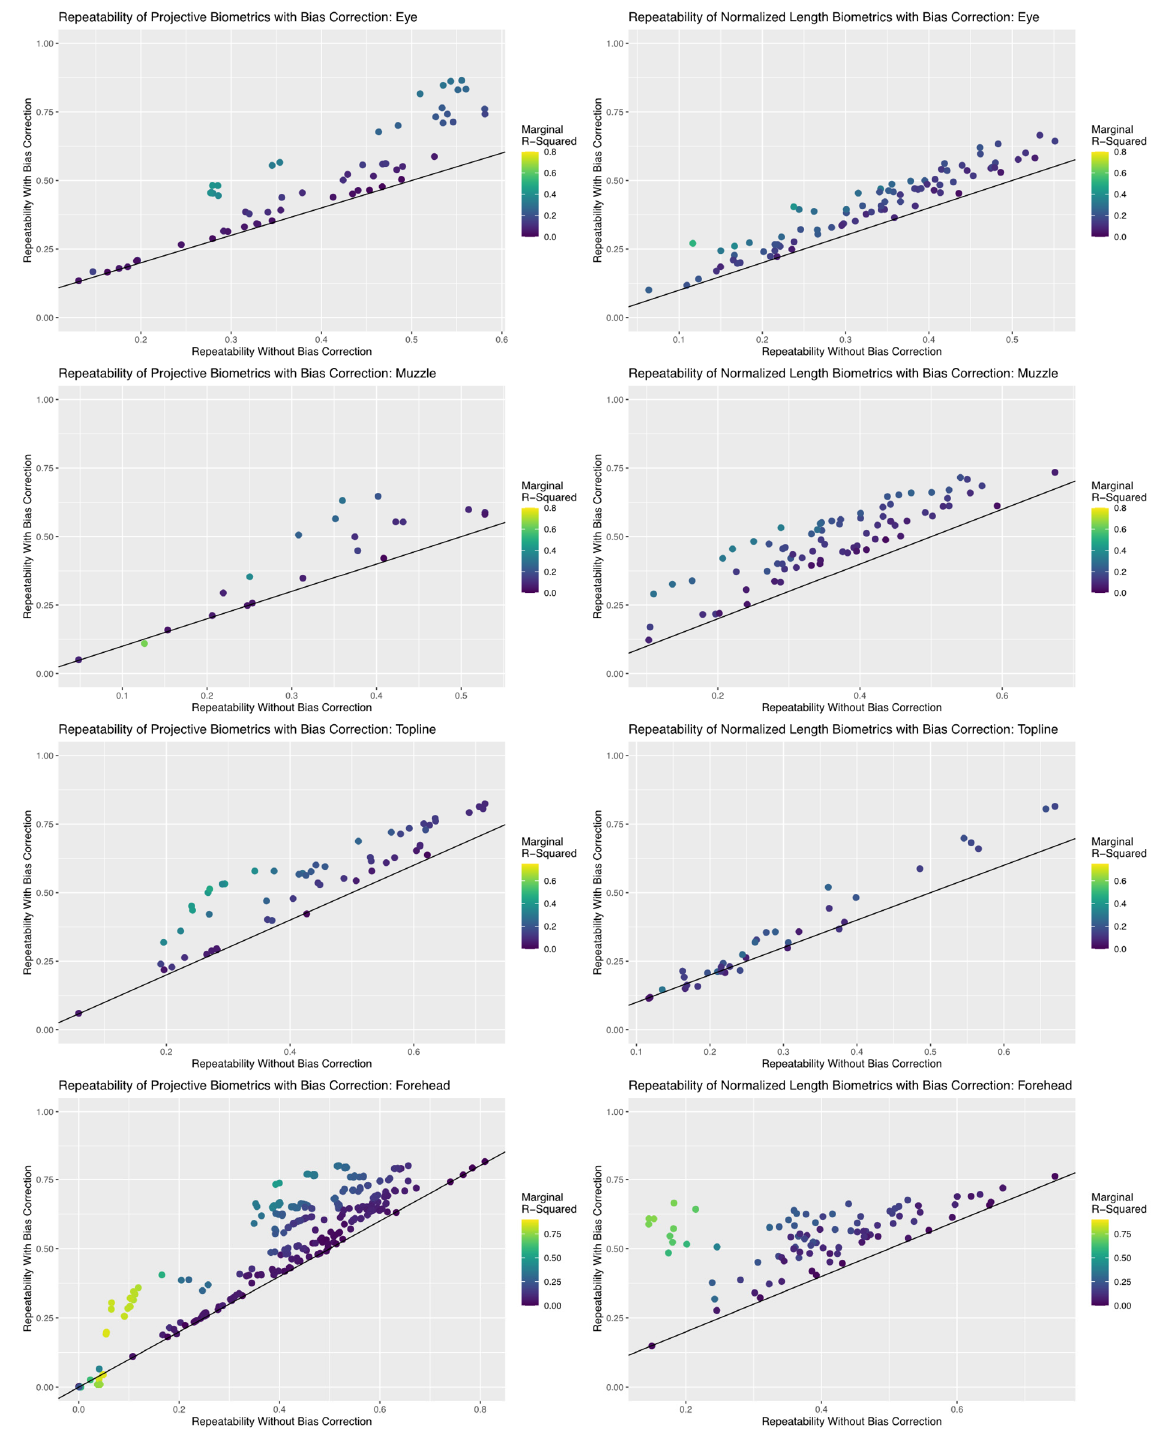
Figure 9. Comparison in the repeatability estimates for each biometric calculated with and without bias correction terms. The black line super-imposed on each scatterplot represents no change in repeatability estimates, such that all points that fall above this line represent an improvement in the reliability of the biometric. Each biometric point is colored by their corresponding marginal R 2 estimate, which represents the total proportion of observed variance in the biometric attributed to the bias correction terms. An appreciable proportion of biometrics show improvements in repeatability with inclusion of these terms for both measurement systems for all anatomical subregions, but the performance of projective biometrics was more strongly impacted for the eye and forehead